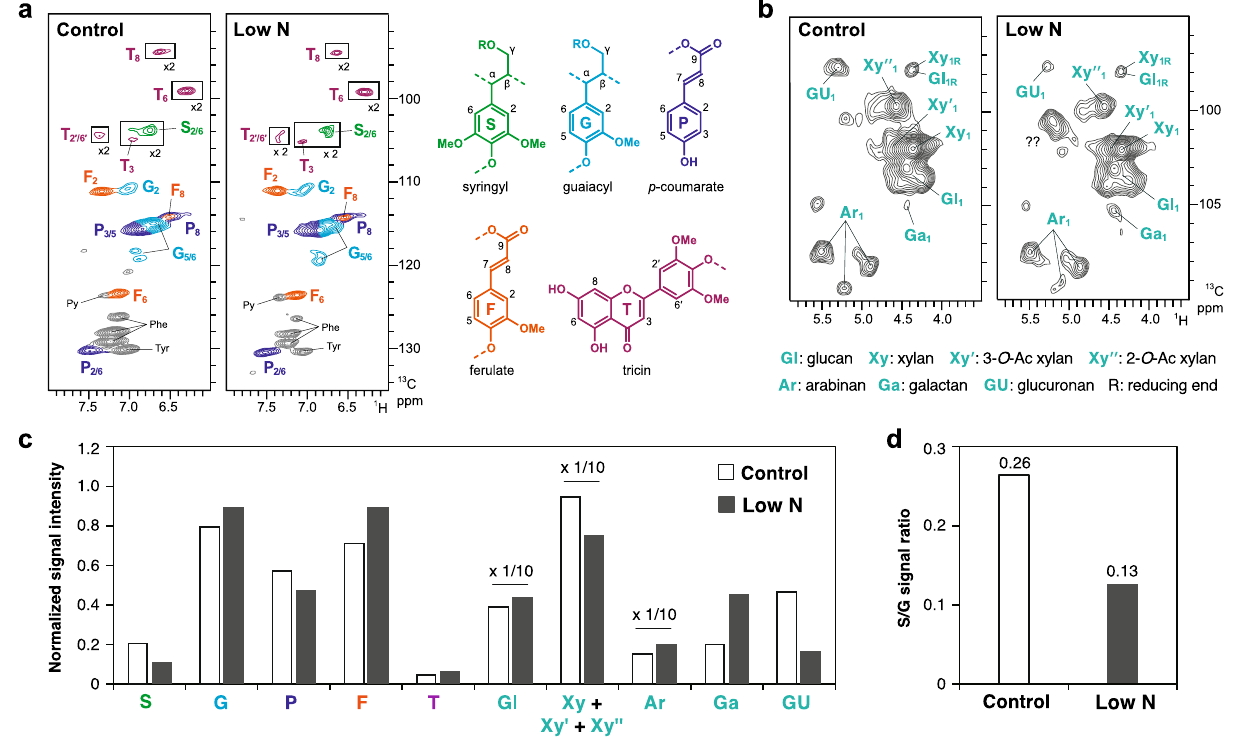
Figure 2. Two-dimensional short-range 1 H- 13 C correlation nuclear magnetic resonance (2D HSQC NMR) spectra of the cell walls of hydroponically-grown sorghum seedlings cultivated under control and low-N conditions at 3 weeks after treatment. The NMR spectra were acquired with composite samples prepared from three replicates. ( a ) Aromatic sub-regions showing signals from major lignin hydroxycinnamate aromatic units. Contours are color-coded to match the displayed structures. Boxes labeled × 2 means regions with scale vertically enlarged twofold. ( b ) Anomeric sub-regions showing signals from major cell wall polysaccharide units. Py, pyridine (solvent). Phe and Tyr, phenylalanine and tyrosine residues in residual proteins 45 . ( c ) Normalized intensity of major lignin, hydroxycinnamate and polysaccharide signals expressed on a S + G = 1 basis. Data labeled × 1/10 indicate that the reported values are divided by a factor 10 for visualization purposes. ( d ) S/G signal